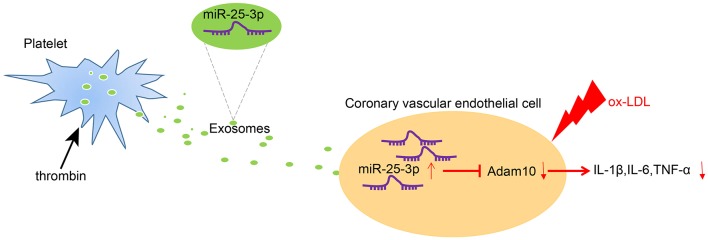
Schematic representation of PLT-Exo containing miR-25-3p in ApoE−/− mouse models of atherosclerosis. Exosomes derived from platelets containing over-expressed miR-25-3p reduce CVEC inflammation induced by ox-LDL through downregulating the Adam10-mediated NF-κB signaling pathway, as reflected with suppressed levels of IL-1β, IL-6, and TNF-α.